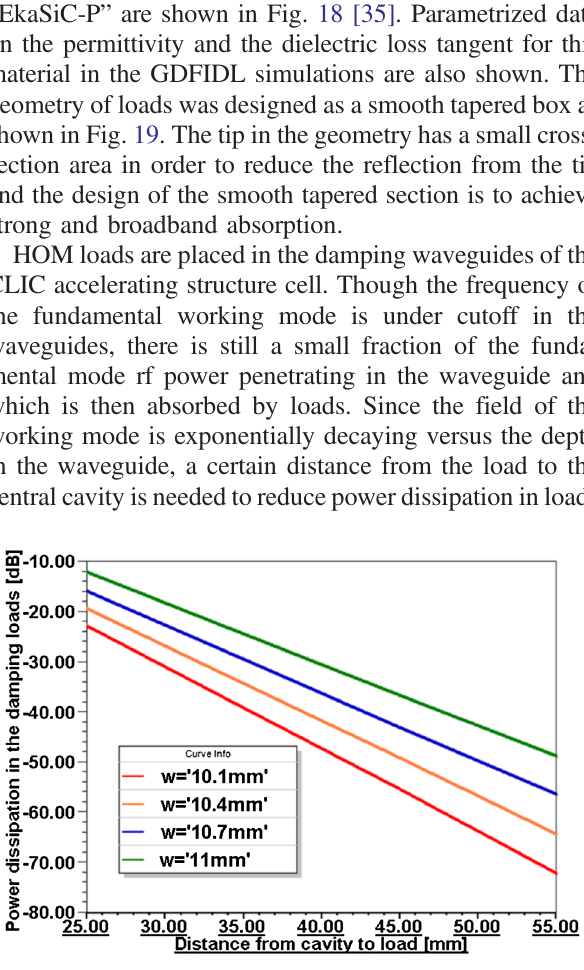
FIG. 20. Power dissipation in the damping load of working frequency ( 0 dB ¼ power dissipation in the cell wall) versus the distance